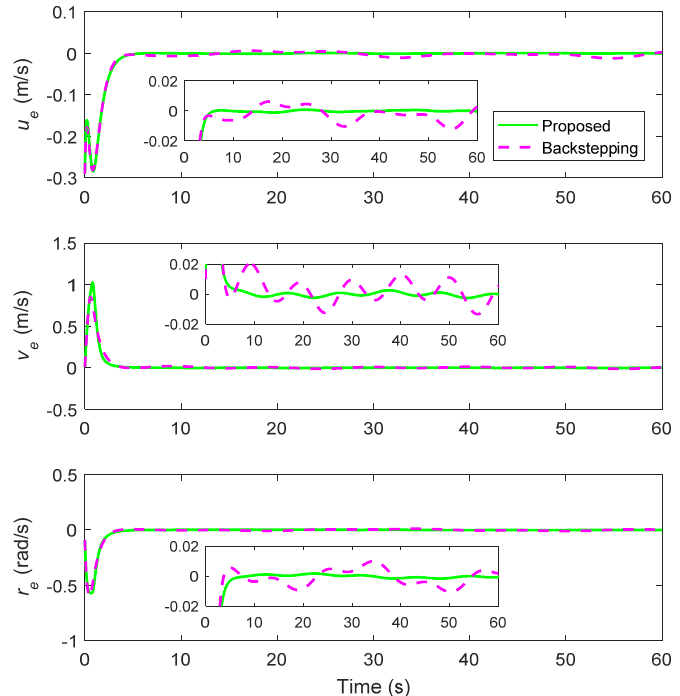
Figure 15. Profile of the velocity tracking errors (Case 2). Figure 15. Pro fi le of the velocity tracking errors (Case 2). Figure 15. Pro fi le of the velocity tracking errors (Case 2).